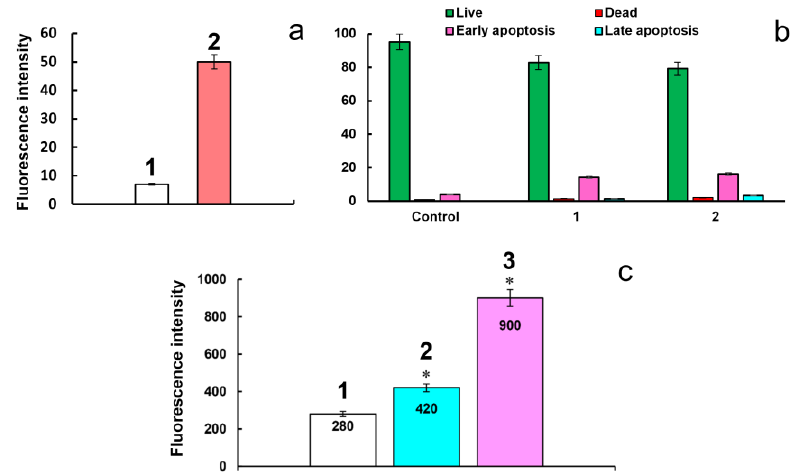
Figure 9. ( a ) Study of cellular uptake of F-127-Cu 2 I 2 L 3 by M-HeLa cells: 1—control, 2—15 μM. ( b ) Induction of apoptosis in M-HeLa cells incubated with F-127-Cu 2 I 2 L 3 at concentrations of 40 μM (1) and 80 μM (2). ( c ) The intracellular ROS generation by F-127-Cu 2 I 2 L 3 : 1—control, 2—40 μM, 3—80 M. The values are presented as mean ± SD of three independent experiments.